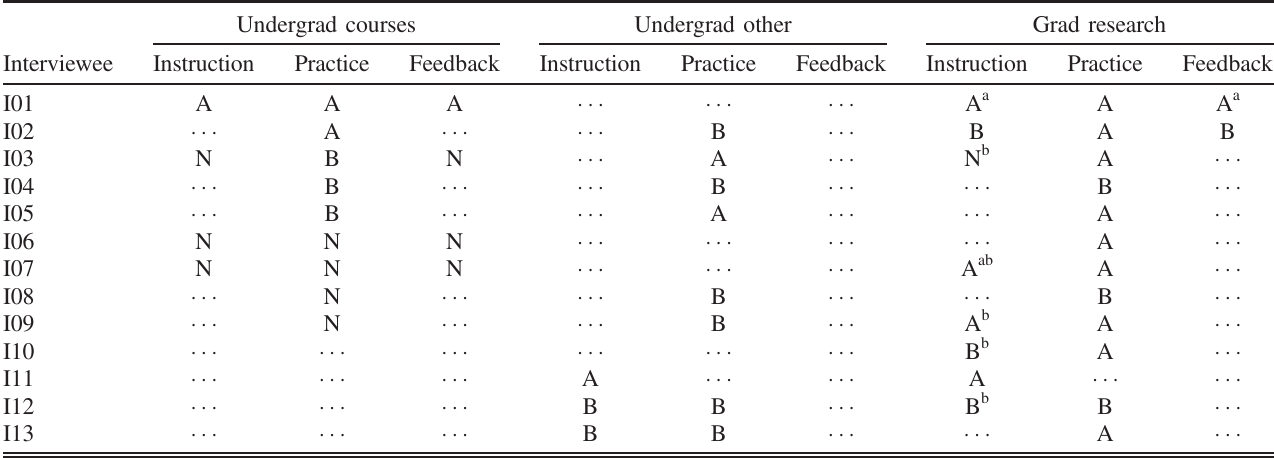
TABLE II. Results of the third stage of coding as described in Sec. II. Adequate ( A ), Beneficial ( B ), Not beneficial ( N ), and Not present ( (cid:1) (cid:1) (cid:1) ) correspond to the codes in Table